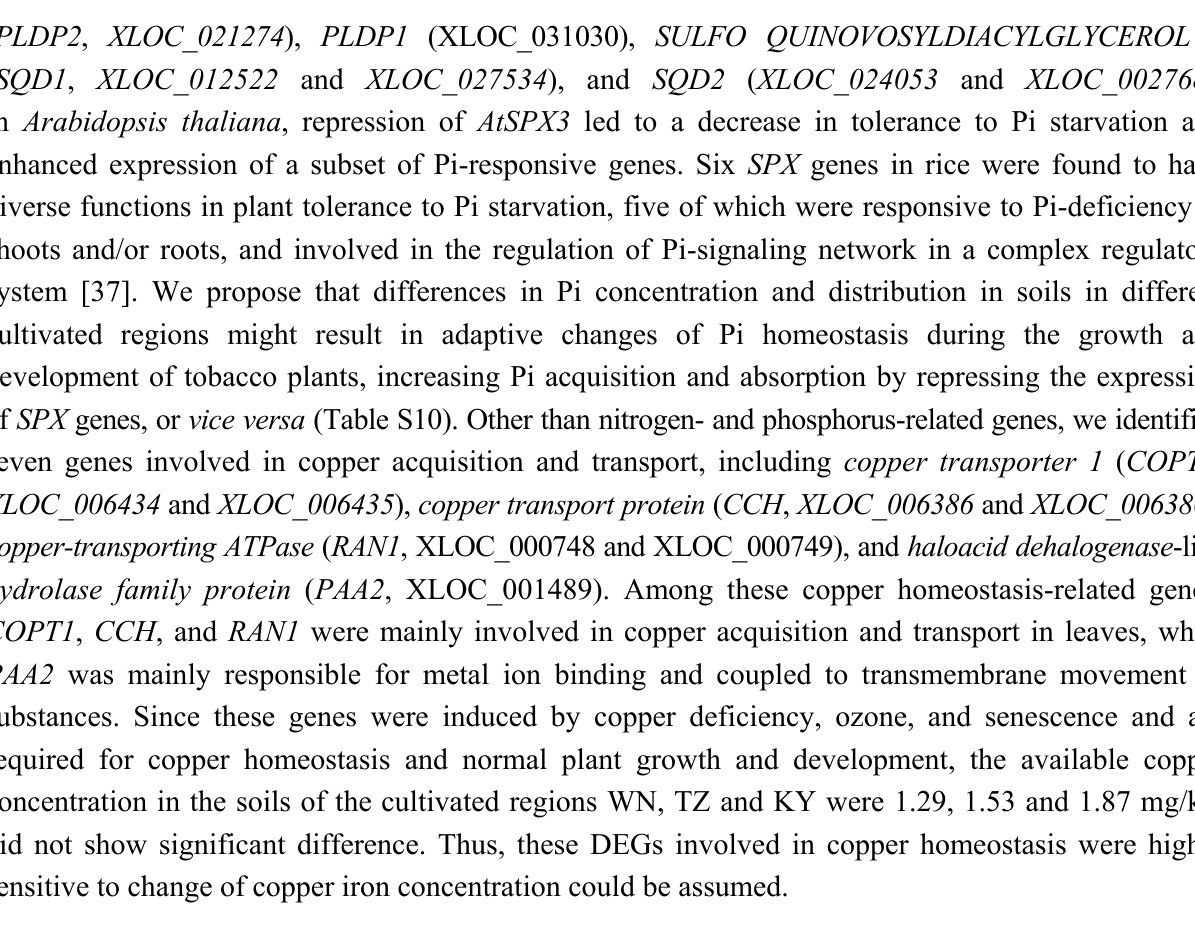
Table 5. Over-represented GO terms of SF-specific